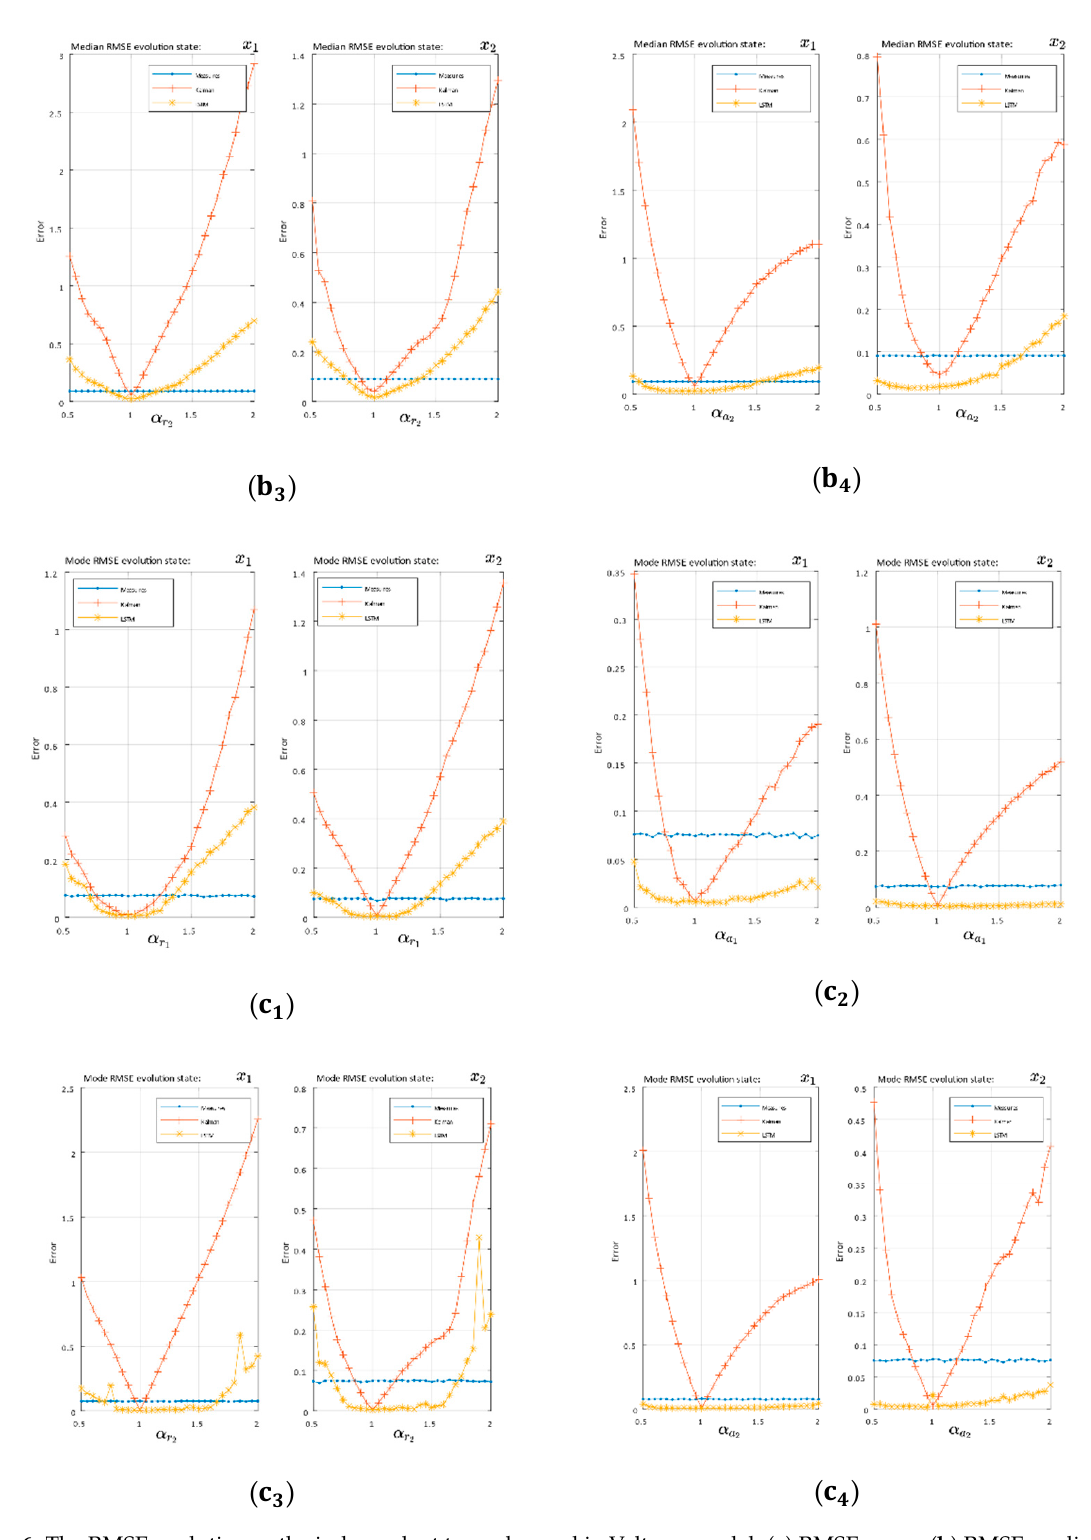
Figure 6. The RMSE evolution as the independent term changed in Volterra model: ( a ) RMSE mean, ( b ) RMSE median, and ( c ) RMSE mode. Subscripts indicate Volterra constant terms: [ 1,2,3,4 ]= [ r 1 , a 1 , r 2 , a 2 ] . Volterra system: Based on the statistical values of the mean and median RMSE with Volterra’s system trajectory, the EKF sensitivity to changes in the independent terms are shown in Figure